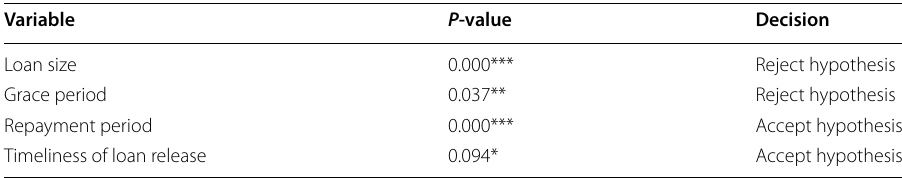
Table 3 Hypothesis